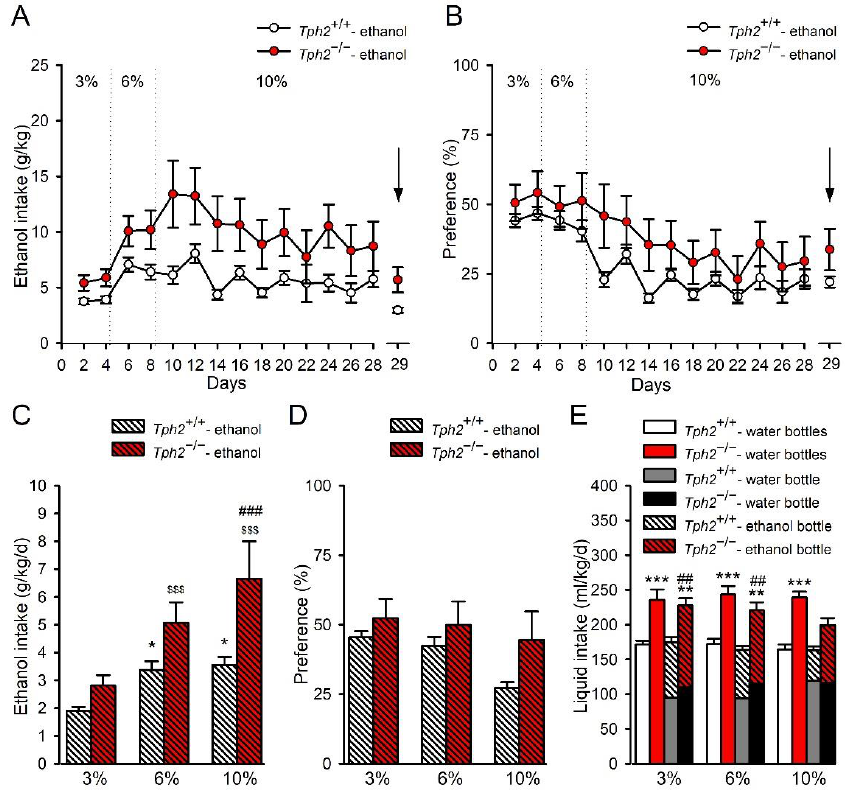
Figure 1. Ethanol consumption in Tph2 −/− deficient mice in a two-bottle choice test. Mice were exposed to a two-bottle (water and ethanol) free-choice paradigm in home cages for 29 days (ethanol: 3% v / v , 4 days; 6% v / v , 4 days; 10% v / v , 21 days). Animals that were given access to two bottles of water were used as controls. Liquid (alcohol and water) intake was measured by weighing the bot- tles in 2-day trials for 28 days. On the final day of ethanol drinking (day 29), liquid intake was meas- ured after 24 h, and mice were introduced to the forced swim test (FST). Immediately after the test, animals were killed by decapitation (black arrow) and the brain tissue was collected. The following parameters were measured: ( A ) ethanol intake—g of pure ethanol consumed per kg of body weight per 1 or 2 days, (g/kg); ( B ) preference—g of ethanol solution consumed per total amount of liquid, %; ( C ) average intake of ethanol during the first 4 days of each concentration of ethanol, (g/kg/d); ( D ) preference during 4 days of each concentration of ethanol, %; ( E ) average intake of total liquid during 4 days of each concentration of ethanol—mL of total liquid (water or water + ethanol) con- sumed per kg of body weight per day, (mL/kg/d). The data are expressed as the means (± SEM) of the data from 5–17 mice/group. ( A ) genotype effect: p < 0.01, day effect: p < 0.001; ( B ) day effect: p < 0.001; ( C ) post hoc Newman–Keuls: * p < 0.05 vs. Tph2 +/+ - ethanol (3%); $$$ p < 0.001 vs. Tph2 −/− - ethanol (3%); ### p < 0.001 vs. Tph2 +/+ - ethanol (10%); ( D ) ethanol dose effect: p < 0.001 10% ethanol vs. 3% or 6%; ( E ) liquid intake: post hoc Newman–Keuls: ** p < 0.01, *** p < 0.001 vs. appropriate Tph2 +/+ - water group; ## p < 0.01 vs. appropriate Tph2 +/+ - ethanol group. Water intake: genotype effect: p < 0.01, treatment effect: p < 0.001. There was a significant increase in cumulative (during 29 days) ethanol intake in Tph2 −/− mice in comparison to Tph2 +/+ mice ( Tph2 +/+ : 80.53 ± 4.57 (g/kg/29 d), Tph2 −/− : 139.45 ± 24.80 (g/kg/29 d); t = 2.34, df = 8.55, p = 0.046, η 2 = 0.39). ANOVA analyses showed that the effect of Tph2 deficiency in mice on preference for ethanol did not change depending on ethanol drinking days (no effect of genotype x day interaction (F(13,312) = 0.92, p = 0.53, ηp 2 = 0.037); Figure 1B). However, there was a signif- icant effect of drinking days (F(13,312) = 15.61, p < 0.001, ηp 2 = 0.39), but not genotype